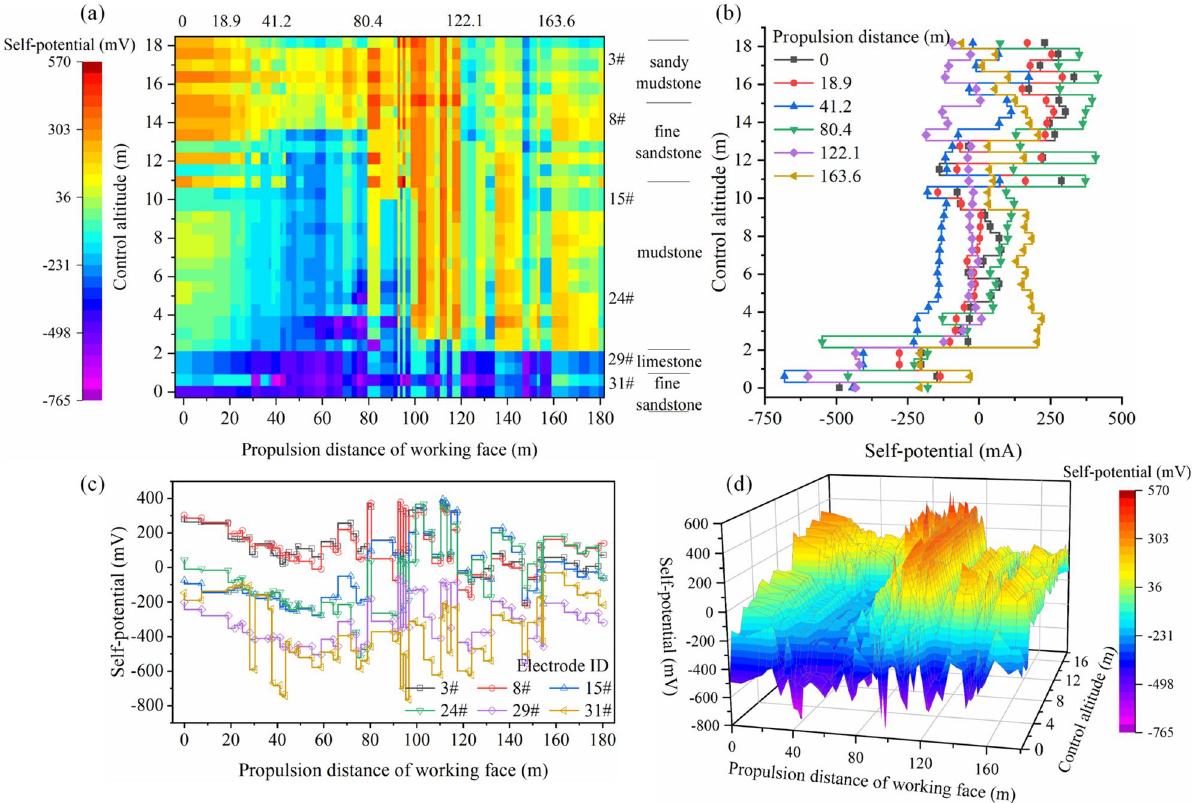
Figure 6. Self-potential changes in the roadway-surrounding rock during mining.